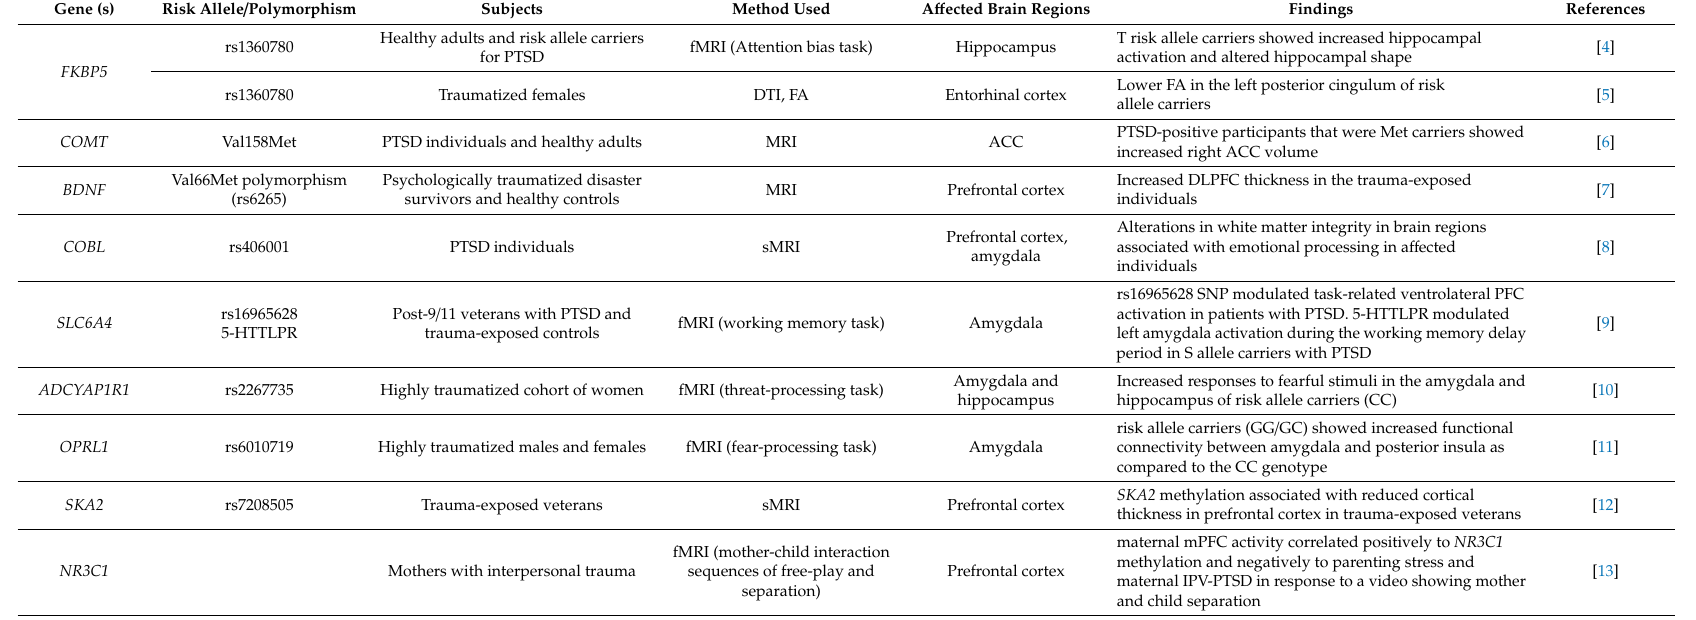
Table 1. Neuroimaging-genetics studies in